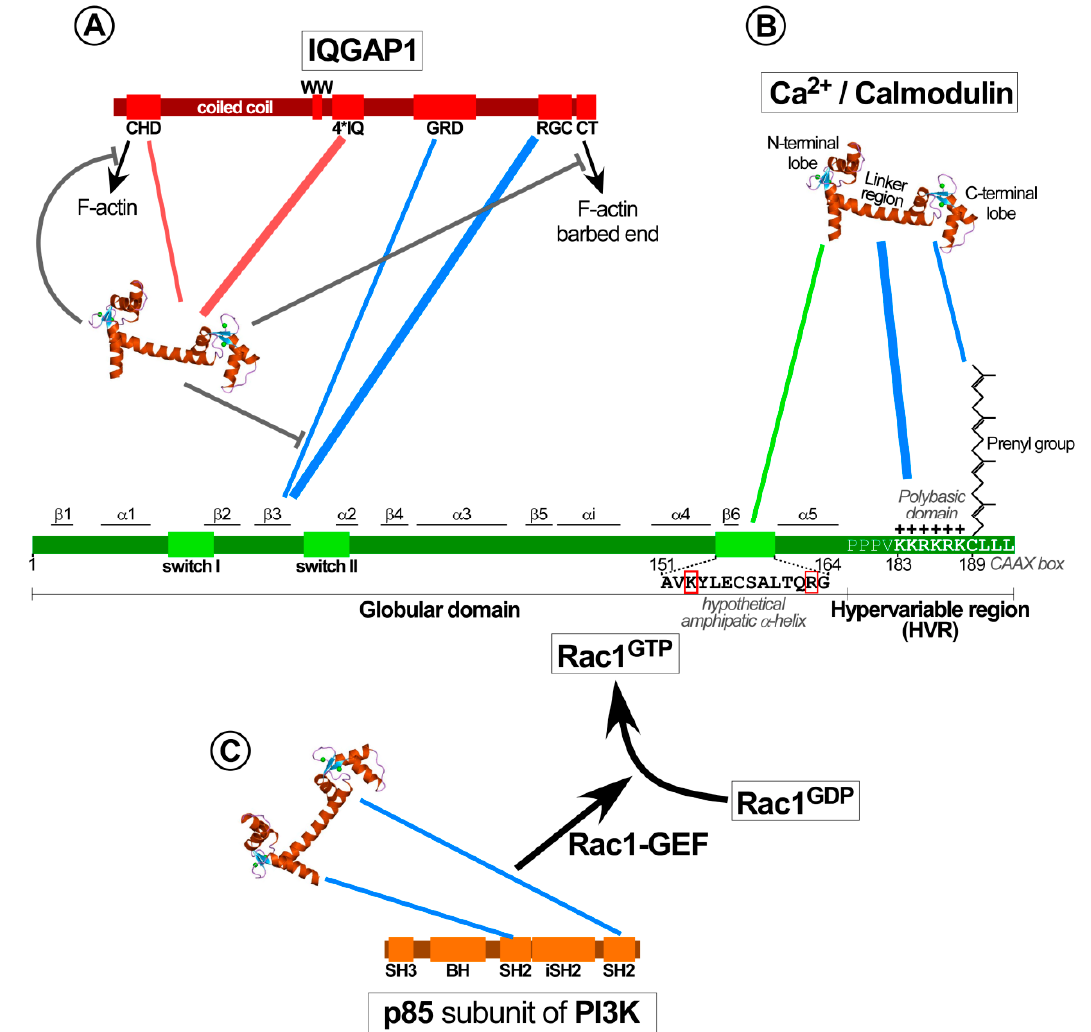
Figure 4. Calmodulin regulates Rac1 signalling through direct and indirect protein–protein interactions. The scheme summarizes the multiple interactions between calmodulin, Rac1, isoleucine–glutamine (IQ) Motif Containing GTPase Activating Protein 1 (IQGAP1) and phosphoinositide 3-kinase (PI3K). Ca 2 + / calmodulin affects Rac1 signalling outcome by directly interacting with Rac1 (A), modulating IQGAP1 / Rac1 interaction (B) or activating PI3K (C). ( A ) Multiple Rac1 domains directly interact with Ca 2 + / calmodulin. Similar to the KRas / calmodulin interaction (see Section 3.3 and Figure 1), the polybasic domain (PBR) and the geranylgeranyl group (prenyl) within the hypervariable region (HVR) of Rac1 are both essential for Ca 2 + / calmodulin binding (blue lines). Based on the well-characterized KRas / calmodulin interaction, one can speculate that the linker domain and C-terminal lobe of calmodulin interact with the PBR and prenyl group of Rac1, respectively. In addition, amino acids 151-164 in Rac1 may adopt an amphipathic α -helix that contributes to calmodulin interaction (green line) and Rac1 activation. Within this region, the basic amino acid K153 (thick red square), and to a lesser extend R163 (red square) are critical for the interaction with the N-terminal lobe of calmodulin. The position of the switch I and II domains, the PBR (aa 183-188) and the prenyl group attached to C189 of Rac1 are indicated. The N- and the C-terminal lobes and the linker region of calmodulin as well as two bound Ca 2 + ions in each lobe are also shown. ( B ) IQGAP1 interaction with active Rac1 (Rac1-GTP) is inhibited by Ca 2 + / calmodulin.